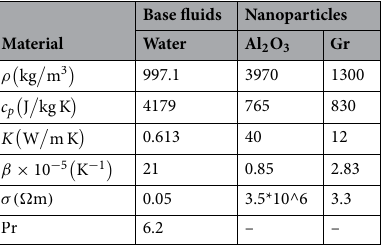
Table 1. Base fluid and nanoparticles thermophysical properties 9 .